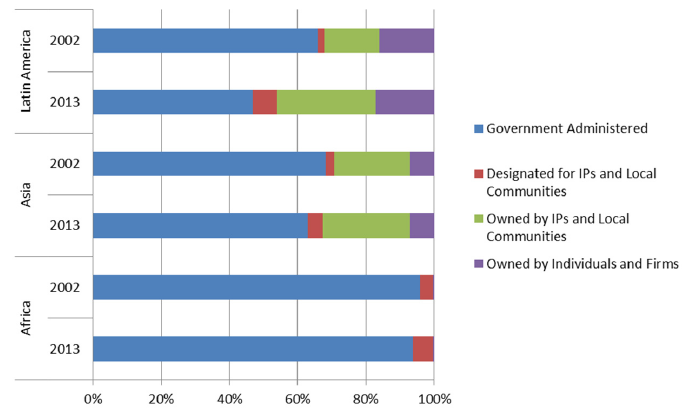
Figure 1. Changes in statutory forest tenure per region, from 2002 to 2013. Public forest ownership is predominant in South America, Asia and Africa. There has been a noticeable increase in forest area designated for indigenous peoples and local communities in Latin America and Asia. Forest owned by individuals and firms has increased in all three regions since 2002. Source: Rights and Resources Initiative—RRI’s forest tenure database accessible through the Tenure Data Tool. Available at: http://rightsandresources.org/en/resources/tenure ‐ data/.